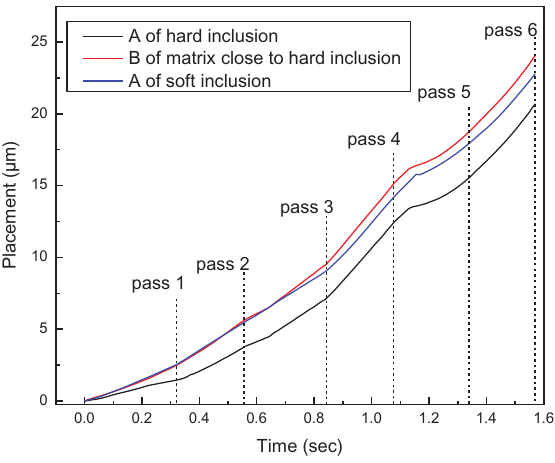
Figure 9: The displacements of A and B during the rolling